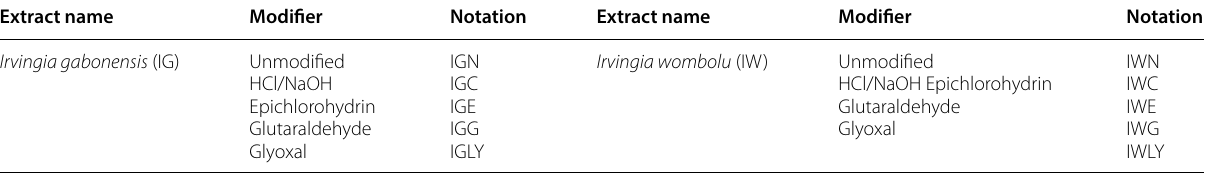
Table 1 Extract origins, modification methods and abbreviations of the samples